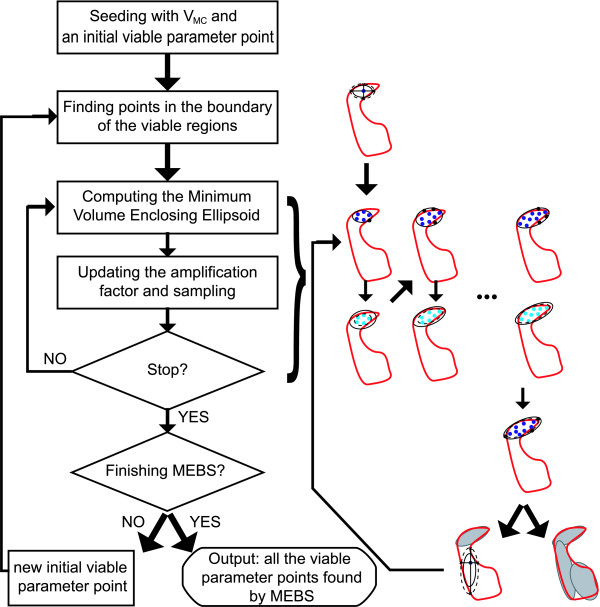
Flowchart for the multiple ellipsoid-based sampling (MEBS) procedure. Given VMC, the set of viable parameter points found by OEAMC, and an initial viable parameter point, the method finds viable parameter points near the boundary of the viable region. Then, it calculates the minimum volume enclosing ellipsoid (MVEE) that encloses those viable parameter points and samples inside an ellipsoid with the same orientation but smaller axes. In the figure, the ellipsoids inside of which sampling is carried out are represented by solid curves; dark blue and black points correspond to viable and nonviable points found in the last sampling, respectively; the MVEE ellipsoids are represented by dashed curves. After the sampling step just desribed, the method again calculates the MVEE of the viable points found so far (light blue points in the figure), and samples inside a scaled ellipsoid with the same orientation but larger axes (7). If the scaling factor tends to one, or a fixed number of iterations is reached, the initial exploration finishes. If this does not happen the method calculates the MVEE of the viable parameter points found and performs a new uniform sampling inside a new scaled ellipsoid. At the end of every new ellipsoid expansion, the algorithm checks if MEBS must stop, which occurs if the algorithm does not find any new viable points in viable nonexplored regions (grey ellipsoids). If MEBS does not stop, it carries out another ellipsoid expansion starting from a different viable parameter point. The result of the MEBS is the set of the viable parameter points found during all the ellipsoid expansions.